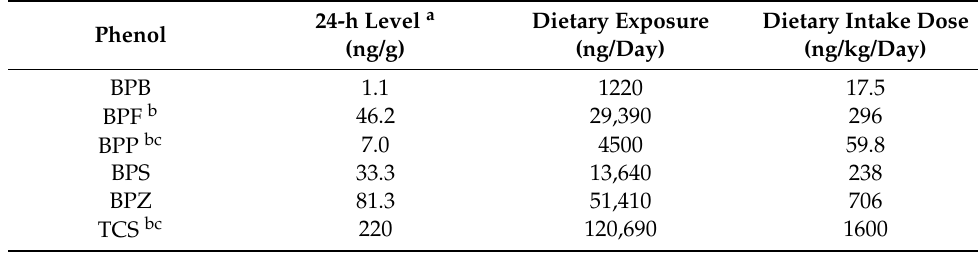
Table 3. The adults’ estimated maximum concentration, dietary exposure and dietary intake dose to each phenol over a 24-h sampling period.